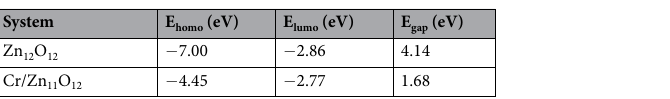
System E homo (eV) E lumo (eV) E gap (eV) Zn 12 O 12 Table 1. Energies of HOMO and LUMO levels and band gap of Zn 12 O 12 and Cr/Zn 11 O 12